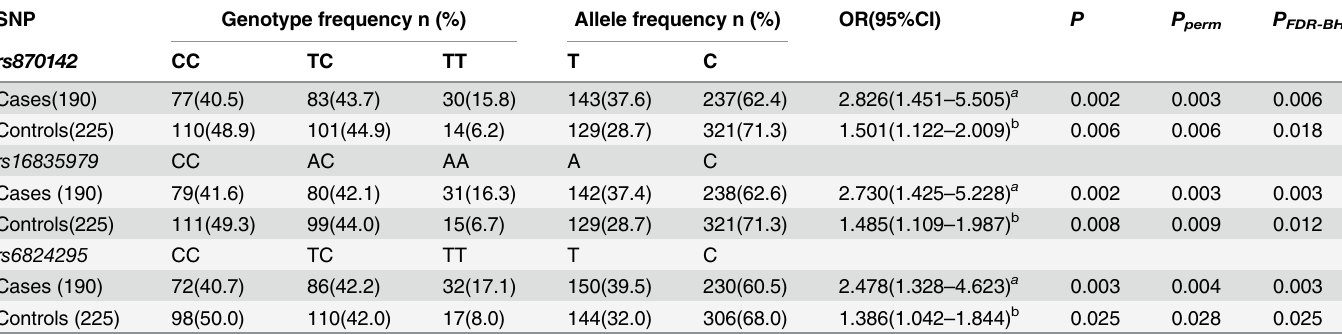
Table 1. Association of rs870142 (T > C), rs16835979 (A > C) and rs6824295 (T > C) polymorphisms with ASD.